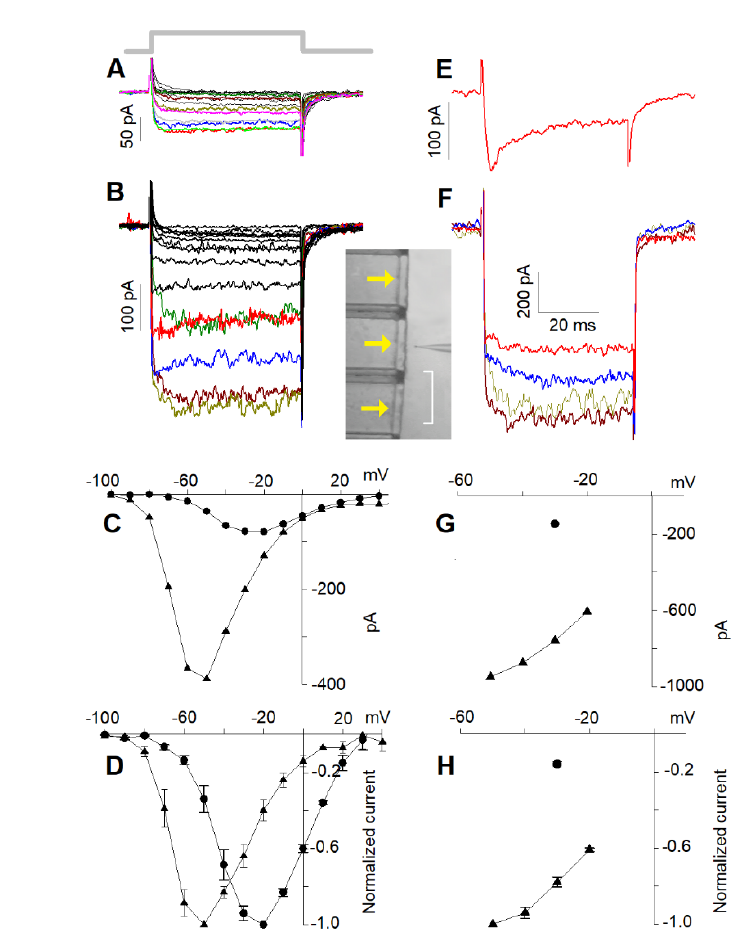
choline) of the fluorescence signals computed in box 1. The lower panel shows the dynamics of Ca 2+ diffusion from the entry site at the basal pole toward the cell apex (box 2) in the control (red number and trace) and during choline perfusion (green). The same time base applies to both electrophysio- logical and fluorescence records.